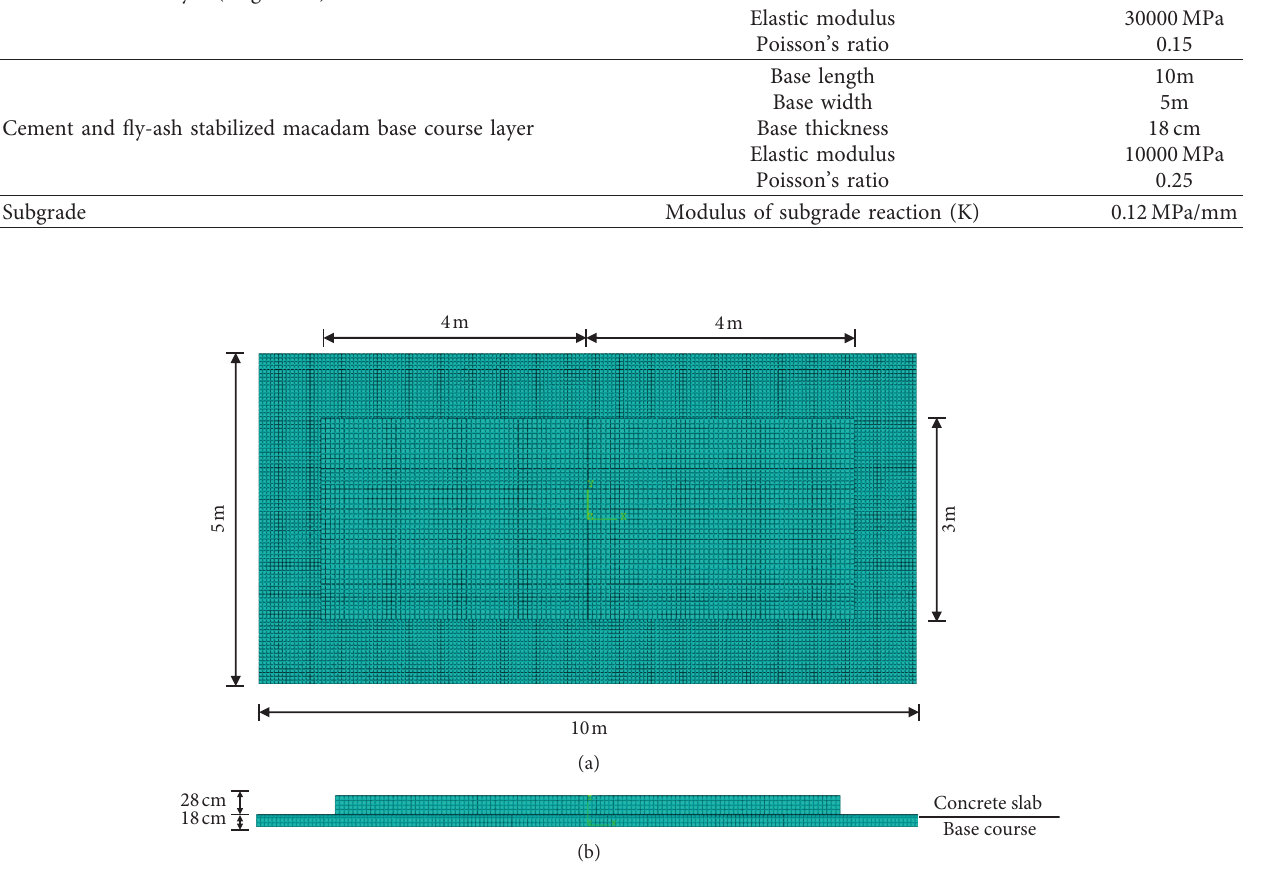
Figure 1: The FEA model of concrete pavement structure: (a) plane size of the model and (b) vertical size of the model.